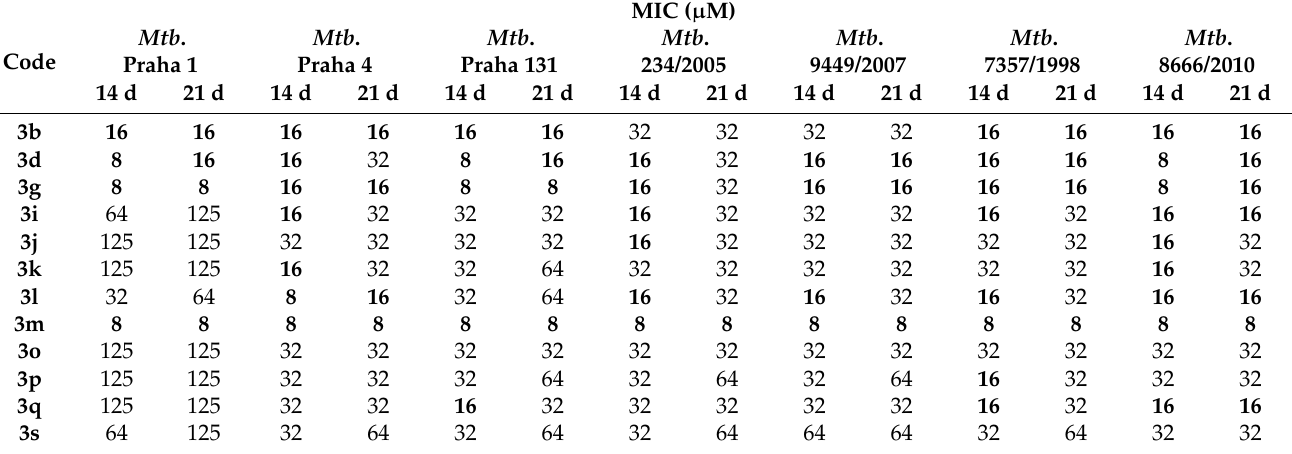
Table 3. Activity of 3 against drug-resistant